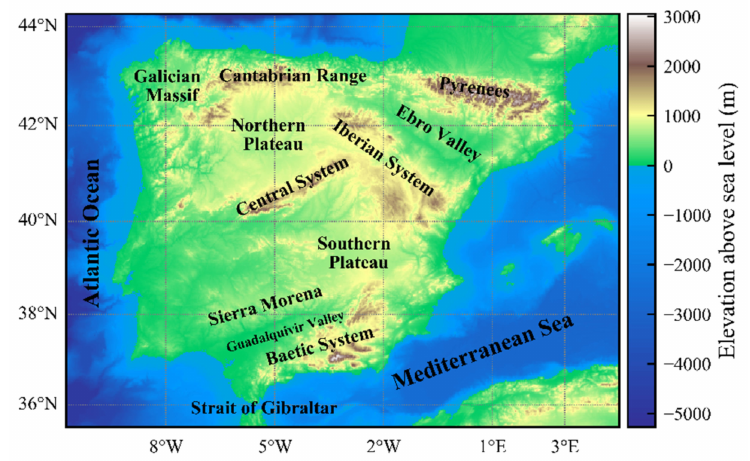
Figure 1. Digital elevation map for the study region with the main topographical